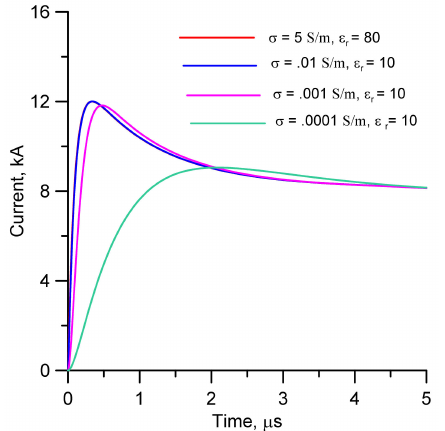
Figure 3. Return stroke current at ground level for four values of the soil conductivity at the strike point. Note that the curves corresponding to σ = 5 S/m and 0.01 S/m fall on each other.